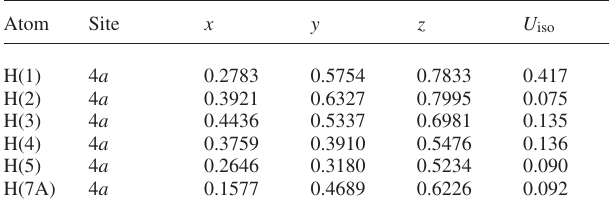
Table 2. Atomic coordinates and displacement parameters (in Å 2 )